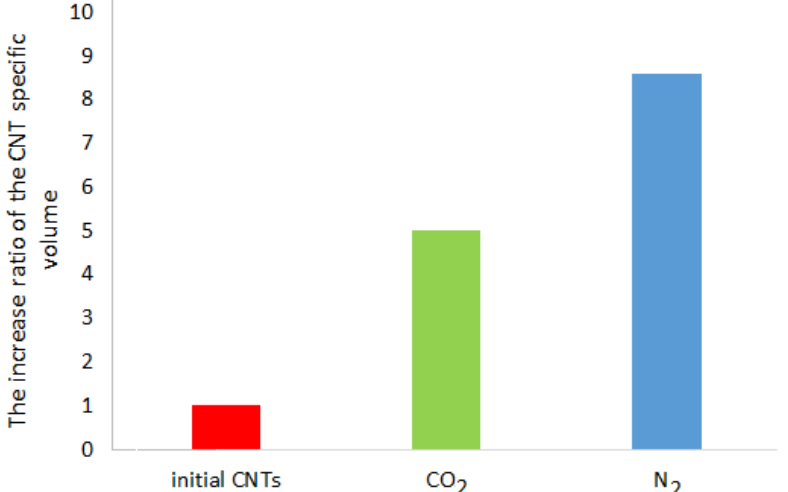
Figure 5. The increase ratio of the CNT specific volume after RESS (Rapid Expansion of Supercritical Suspensions)-processing (100 bar, 40 °C) using CO 2 and N 2